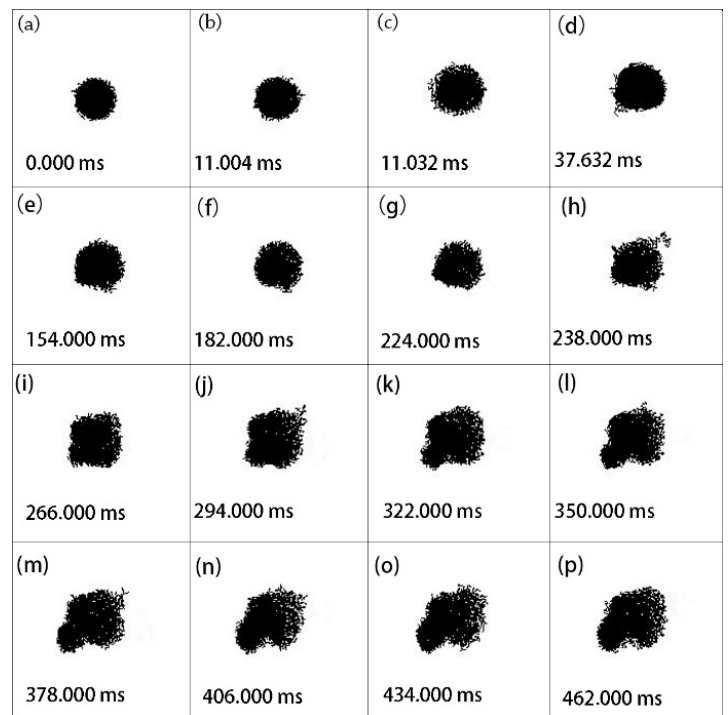
Figure 4. Representative pictures of laser ‐ induced ignition and combustion processes of an individual aluminum particle using digital imaging treatment. The initial diameter was 6.82 μ m. The laser power density was 5.88 × 10 5 W/cm 2 .